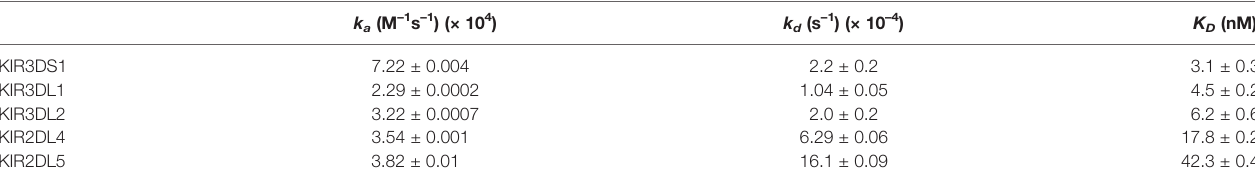
TABLE 2 | Kinetic analyses of KIR-Fc binding to heparan sulfate.